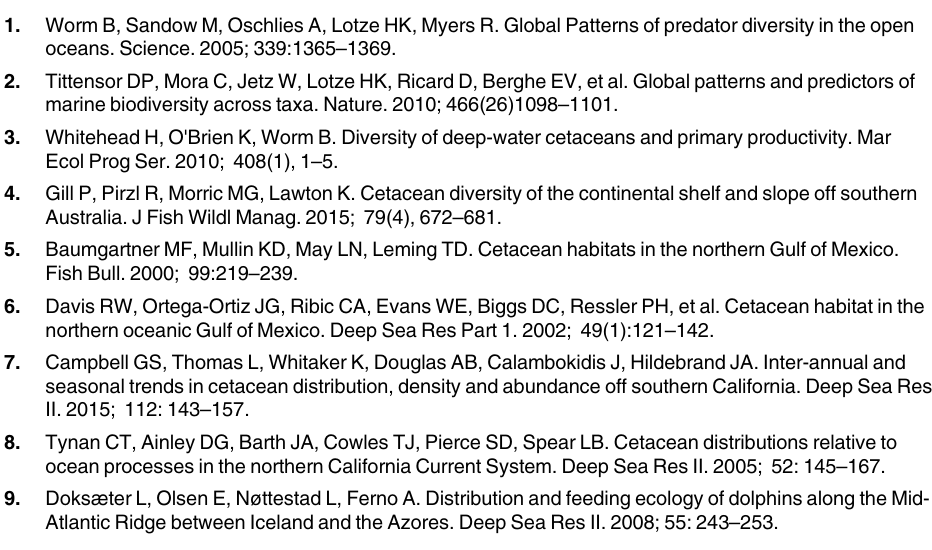
S4 Fig. Encounter rate (ER) distribution of large whales during spring (left) and autumn (right) surveys. Acronyms represent the Brazilian states of Rio Grande do Sul (RS); Santa Catarina (SC); Paraná (PR); São Paulo (SP) and Rio de Janeiro (RJ). Dashed line is the limit between south and southeast areas. Solid grey lines are 200m, 1500m, 2000m isobaths.